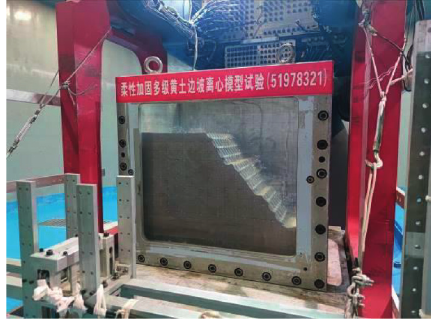
Figure 7: Model slope after placement.